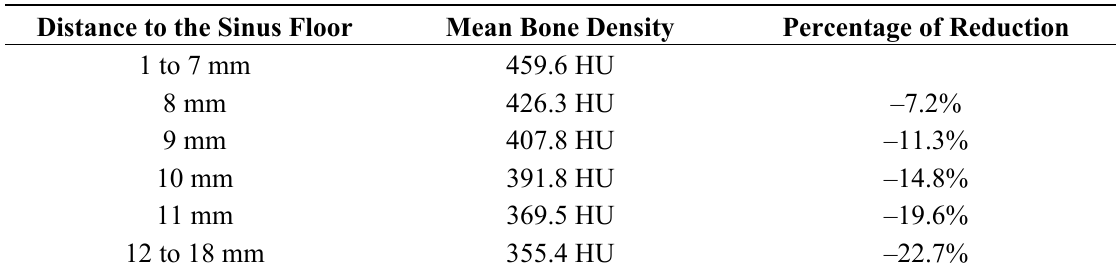
Table 1. Mean bone density in Houndfield Units (HU) in 1 to 18 mm distance to the residual alveolar ridge and percentage of reduction in bone